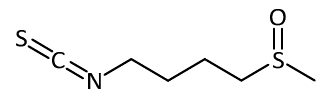
Figure 15. Structure of sulforaphane.